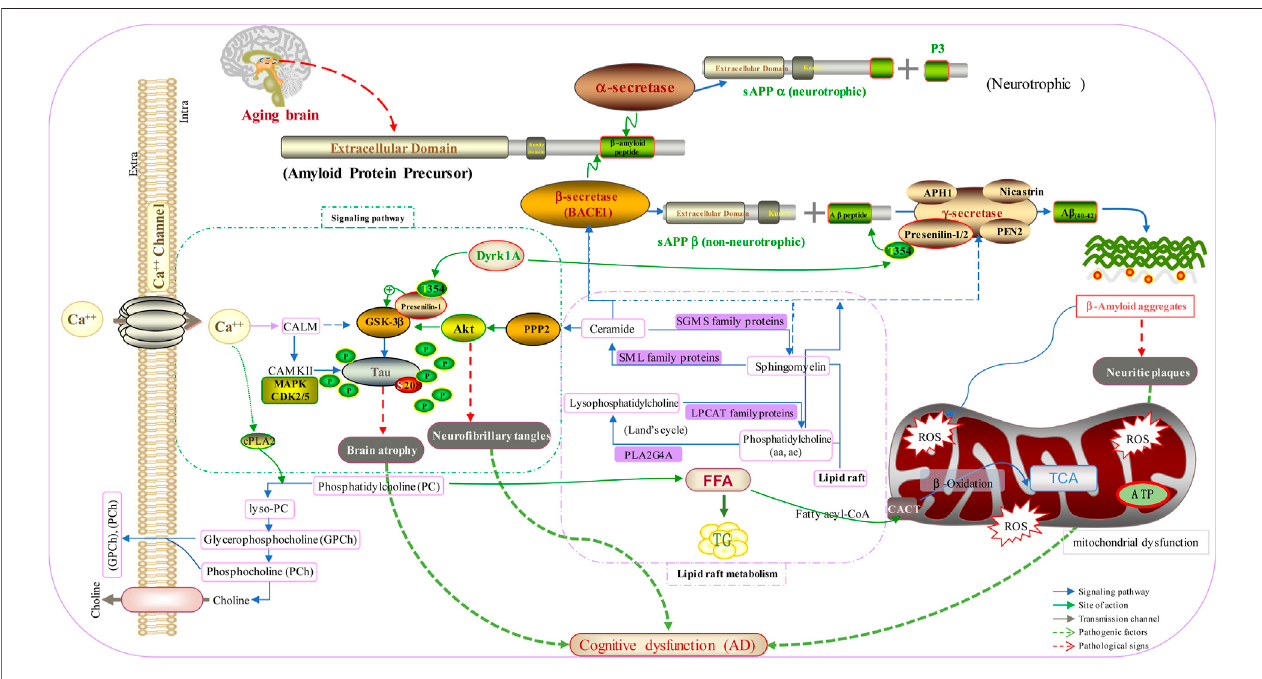
FIGURE 5 | Mechanism based on the brain biomarkers for